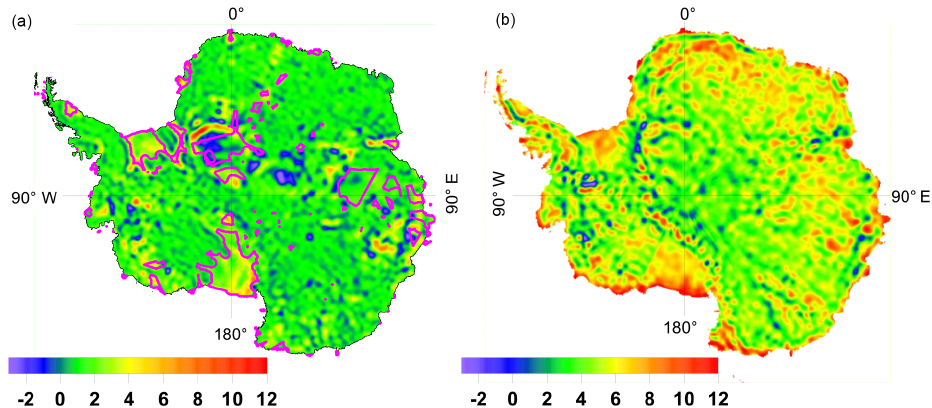
Figure 6. (a) Differences between estimations of crustal thickness: results using BEDMAP minus results using BEDMAP 2. The pink line delimitates the zones where GOCE observations are used in BEDMAP 2. Units are kilometers (km). (b) Differences between the crust thicknesses computed from GOCE and the CRUST1.0 model. Units are kilometers